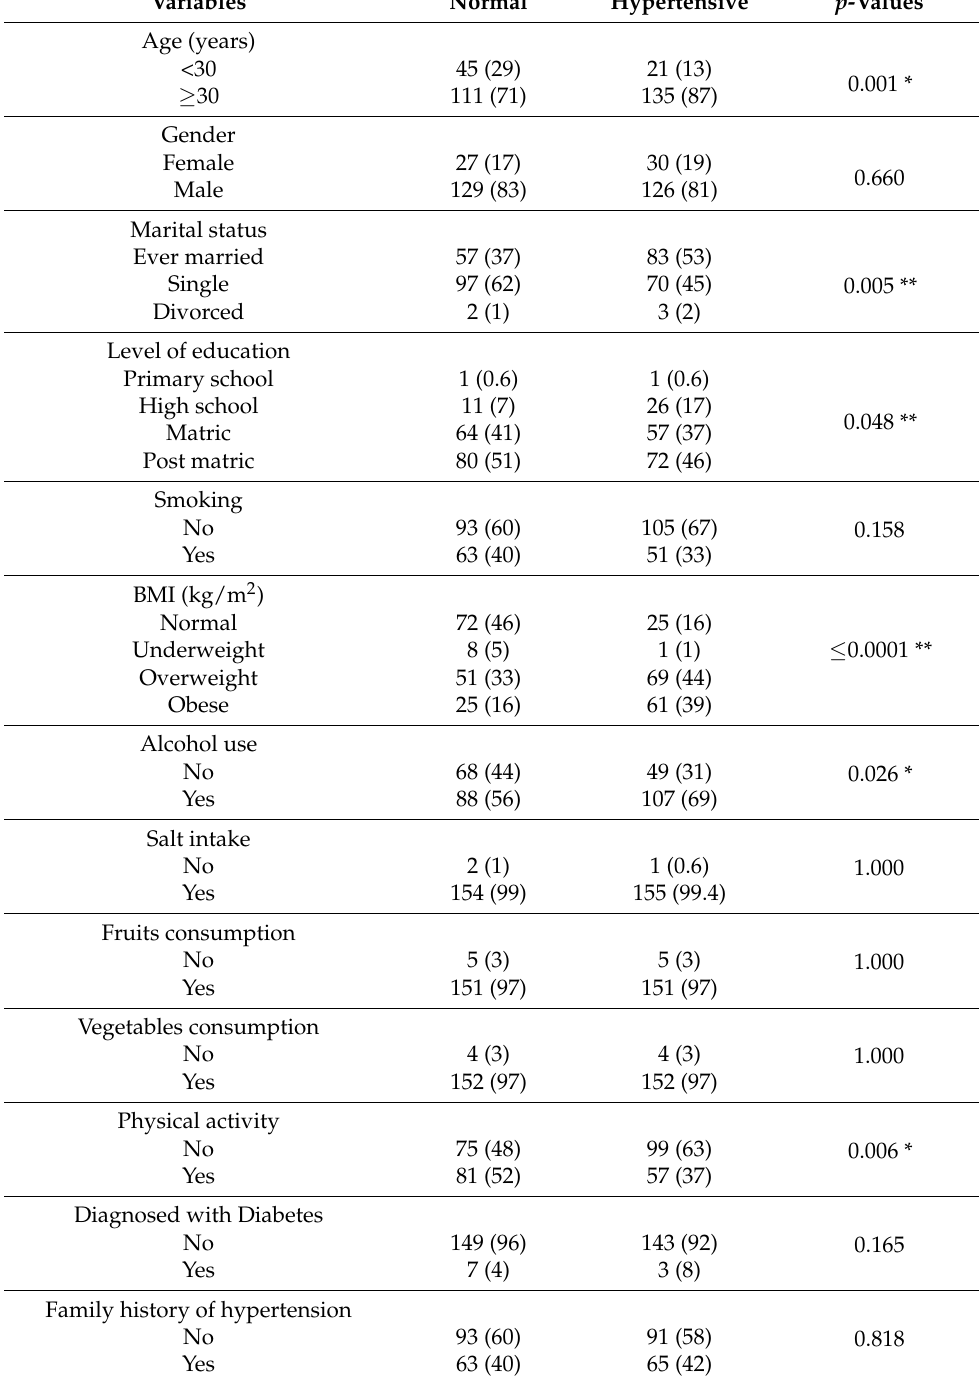
Table 4. Comparison of selected variables by hypertension